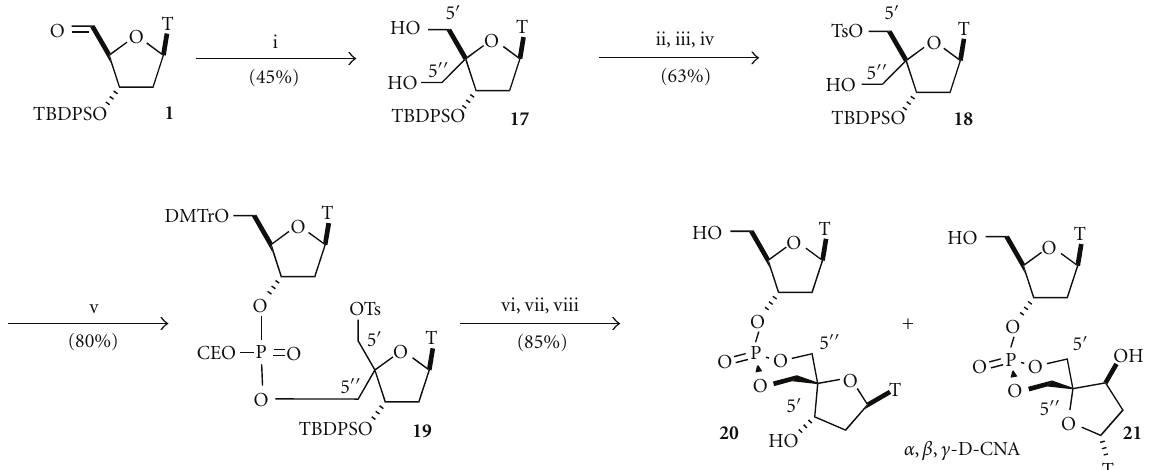
Scheme 3: Synthesis of α , β , γ -Dioxaphosphorinane-Constrained Nucleic Acid dinucleotides ( α , β , γ -D-CNA). Reagents and conditions: (i) HCOH, 2N NaOH, dioxane then NaBH 4 , 45%, (ii) DMTrCl, pyr, 70%, (iii) TsCl, CHCl 3 , Pyr, 90%, (iv) 3% TFA, DCM, quant. (v) 5 (cid:2)